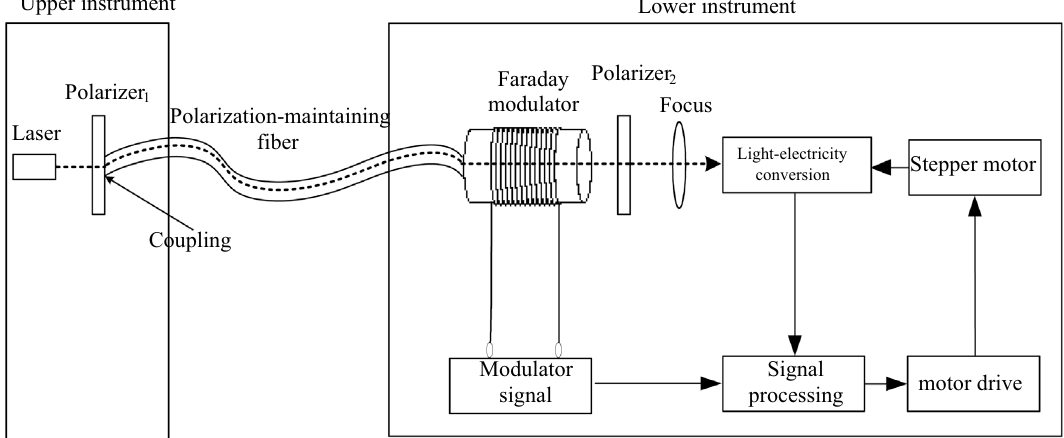
Figure 1. Schematic diagram of azimuth transmission system based on polarization-maintaining